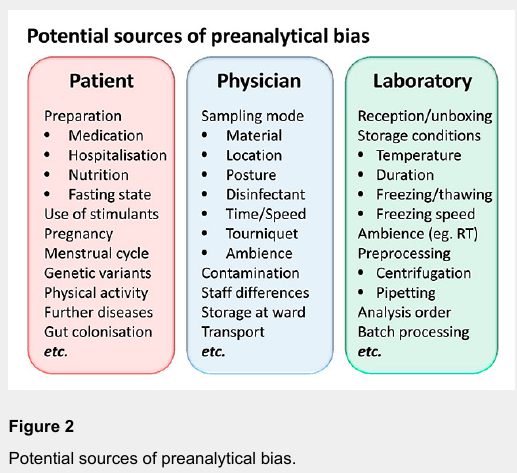
Potential sources of preanalytical bias. RT = room